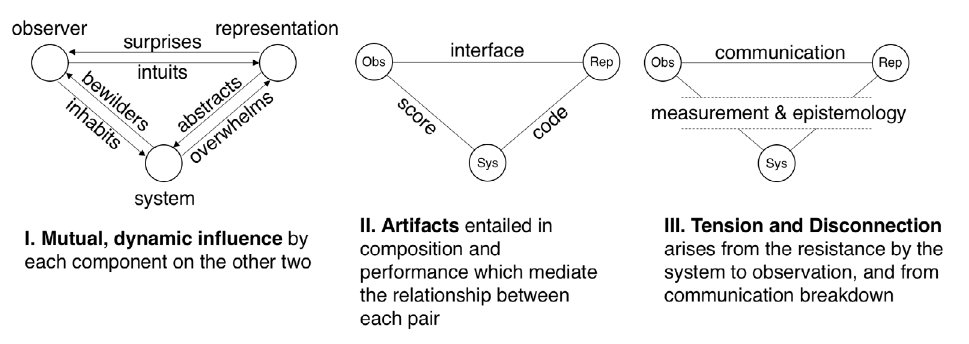
Figure 1: The relationship between each component (system, its representation, and the human observer(s)) entails (I) mutual, dynamic influence, (II) the iterative construction of artifacts, and (III) distinct sources of